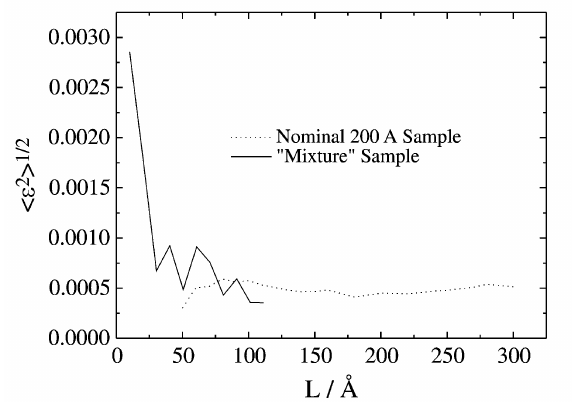
Figure 7. Root mean square averaged strain versus crystallite size deter- mined by the